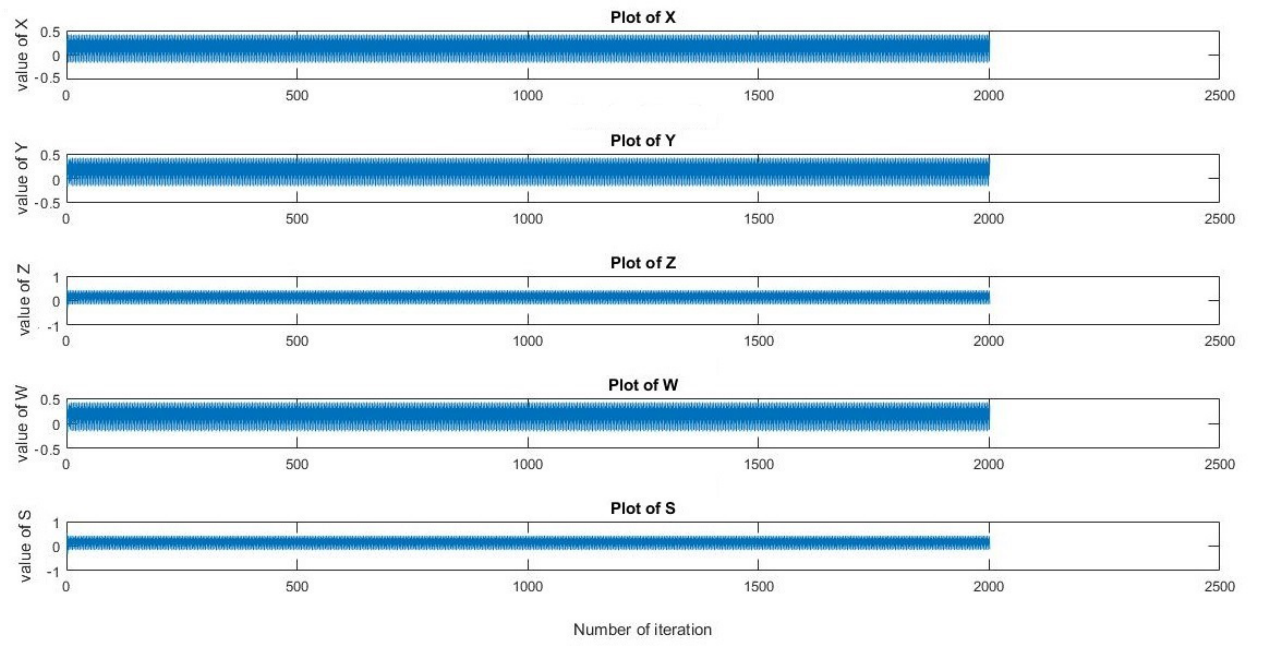
Figure 5. Individual plot for x , y , z , w , and s